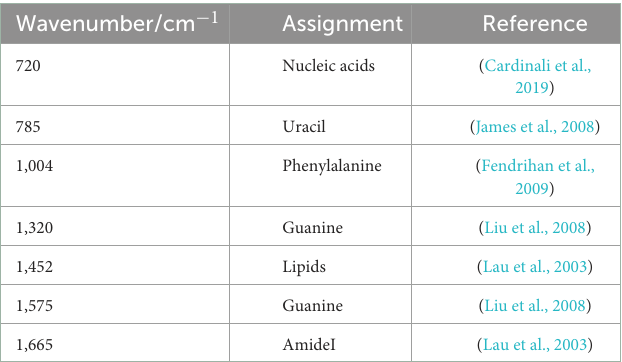
Figure 2, according to the statistical analysis of the line chart and heat map.